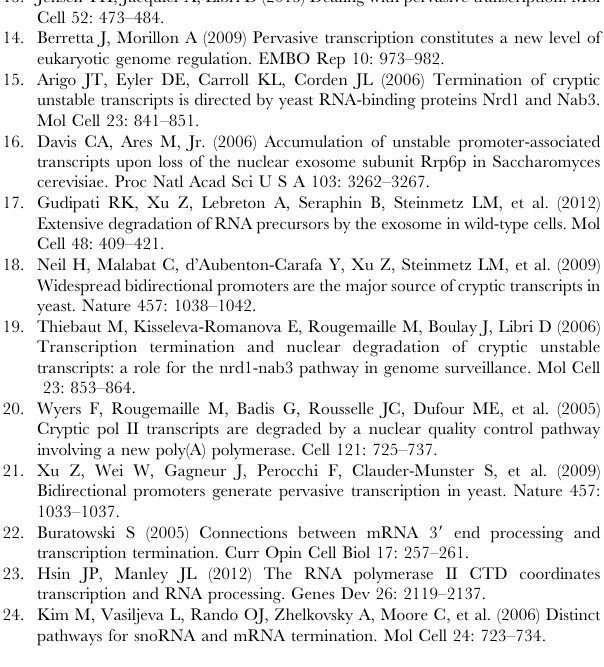
region is also represented in as a histogram below each graph with Sen1 (grey) and without Sen1 (black). Table S1 Read counts at various stages of bioinformatic manipulation. Table S2 Top 266 points of inflection after spline function refinement. CUT annotations are defined in Neil et. al. [18]. NUT annotations are defined in Schulz et. al. [65]. Gene and snoRNA annotations come from the Saccharomyces genome database. Top 144 CUTs highlighted in green. NA is no annotation. Table S3 Top 49 points of inflection 3 9 of snoRNAs after spline function refinement. snoRNA annotations come from the saccharomyces genome database. Table S4 Yeast strains used in this study. Table S5 Primers used in this